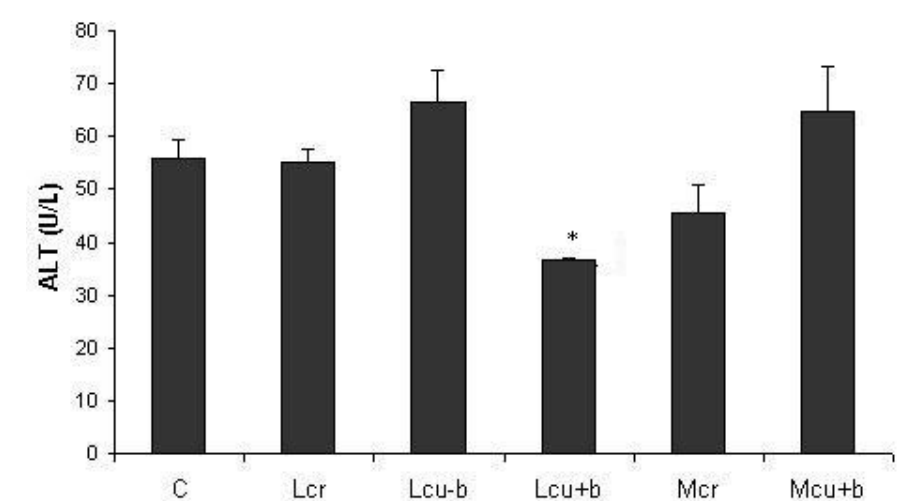
Figure 2. Activity of alanine aminotransferase [ALT (U/L)] in control and treated groups (Lcr, Lcu-b, Lcu+b, Mcr and Mcu+b) after two months of treatment. The values are expressed as mean ± SEM (n = 6). Significant levels observed are * p ≤ 0.05 compared with control group